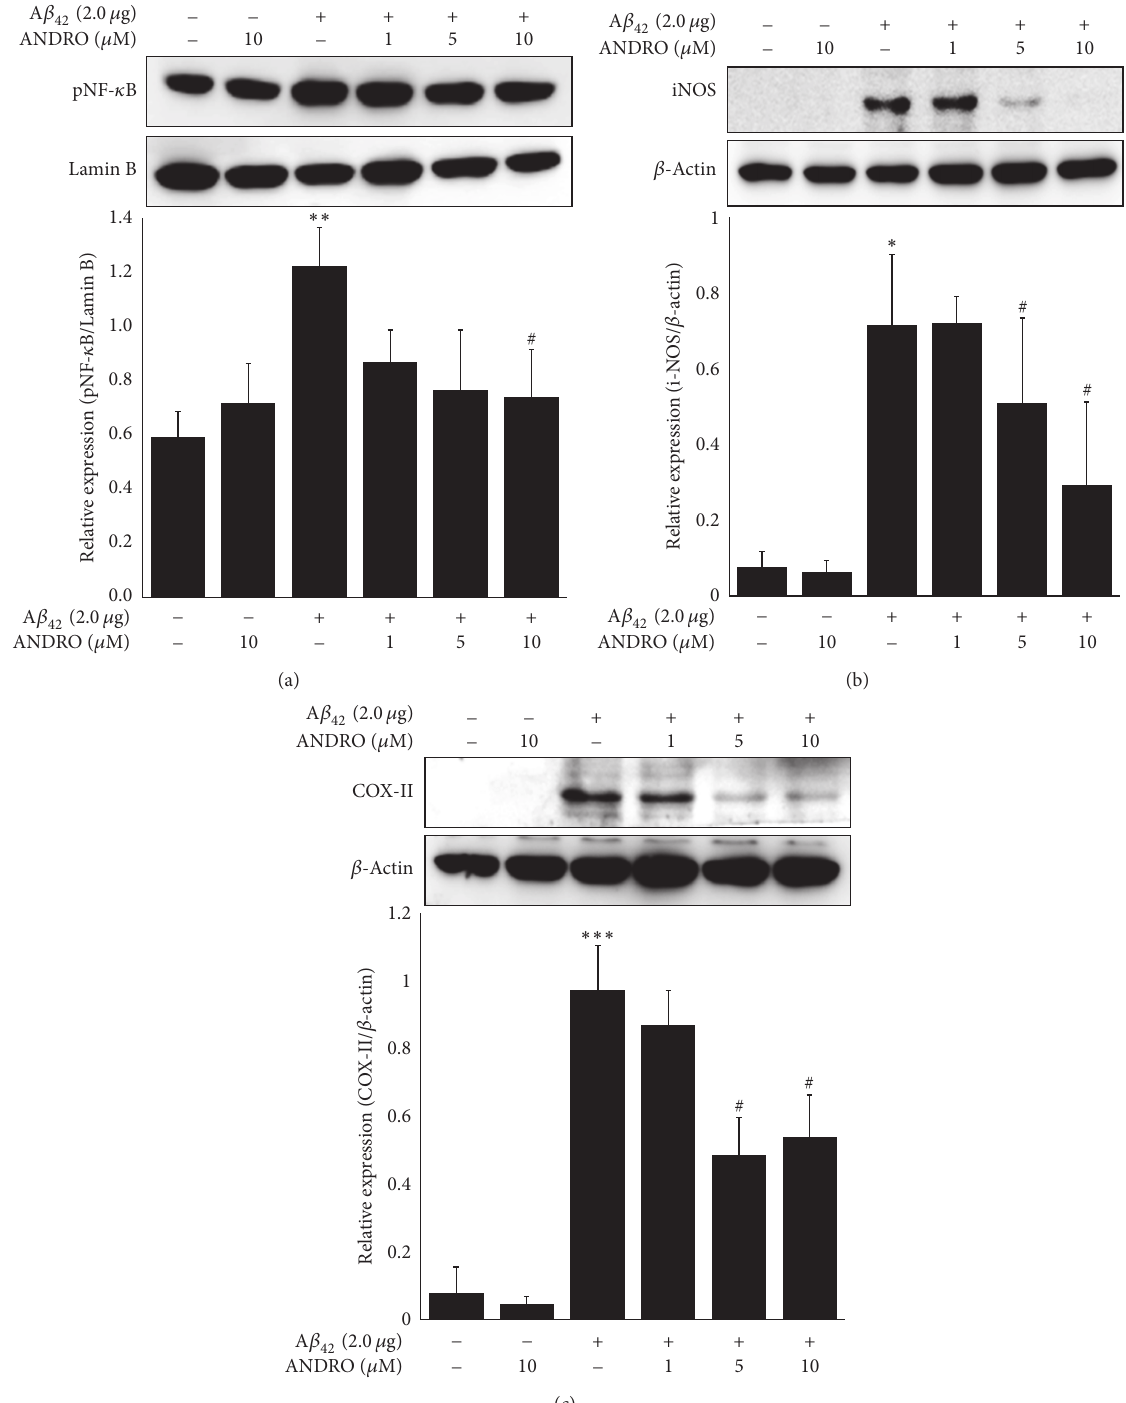
Figure 5: Effect of andrographolide on pNF- 𝜅 B or inflammatory protein expression in BV-2 cells. BV-2 cells were seeded and transfected with A 𝛽 42 plasmids for 12h, and the medium was then replaced with fresh phenol red free medium containing 1, 5, or 10 𝜇 M of andrographolide for 24 h. The abbreviation of andrographolide, ANDRO, was used. (a) Nuclear extracts were used to determine pNF- 𝜅 B (Ser536) accumulation in the nucleus. Lamin B was used as a positive control. The data are presented as the means ± SE of triplicates. The significance presented as ∗∗ 𝑝 < 0.01 compared with control group and # 𝑝 < 0.05 compared with the A 𝛽 42 -transfected group. (b) Whole cell lysates were used to analyze i-NOS expression, determined by Western blot analysis. The data are presented as the means ± SE of triplicates. The significance presented as ∗ 𝑝 < 0.05 compared with control group and # 𝑝 < 0.05 compared with the A 𝛽 42 -transfected group. (c) COX-II expression was analyzed by Western blot analysis. The data are presented as the means ± SE of triplicates. The significance presented as ∗∗∗ 𝑝 < 0.001 compared with control group and # 𝑝 < 0.05 compared with the A 𝛽 42 -transfected